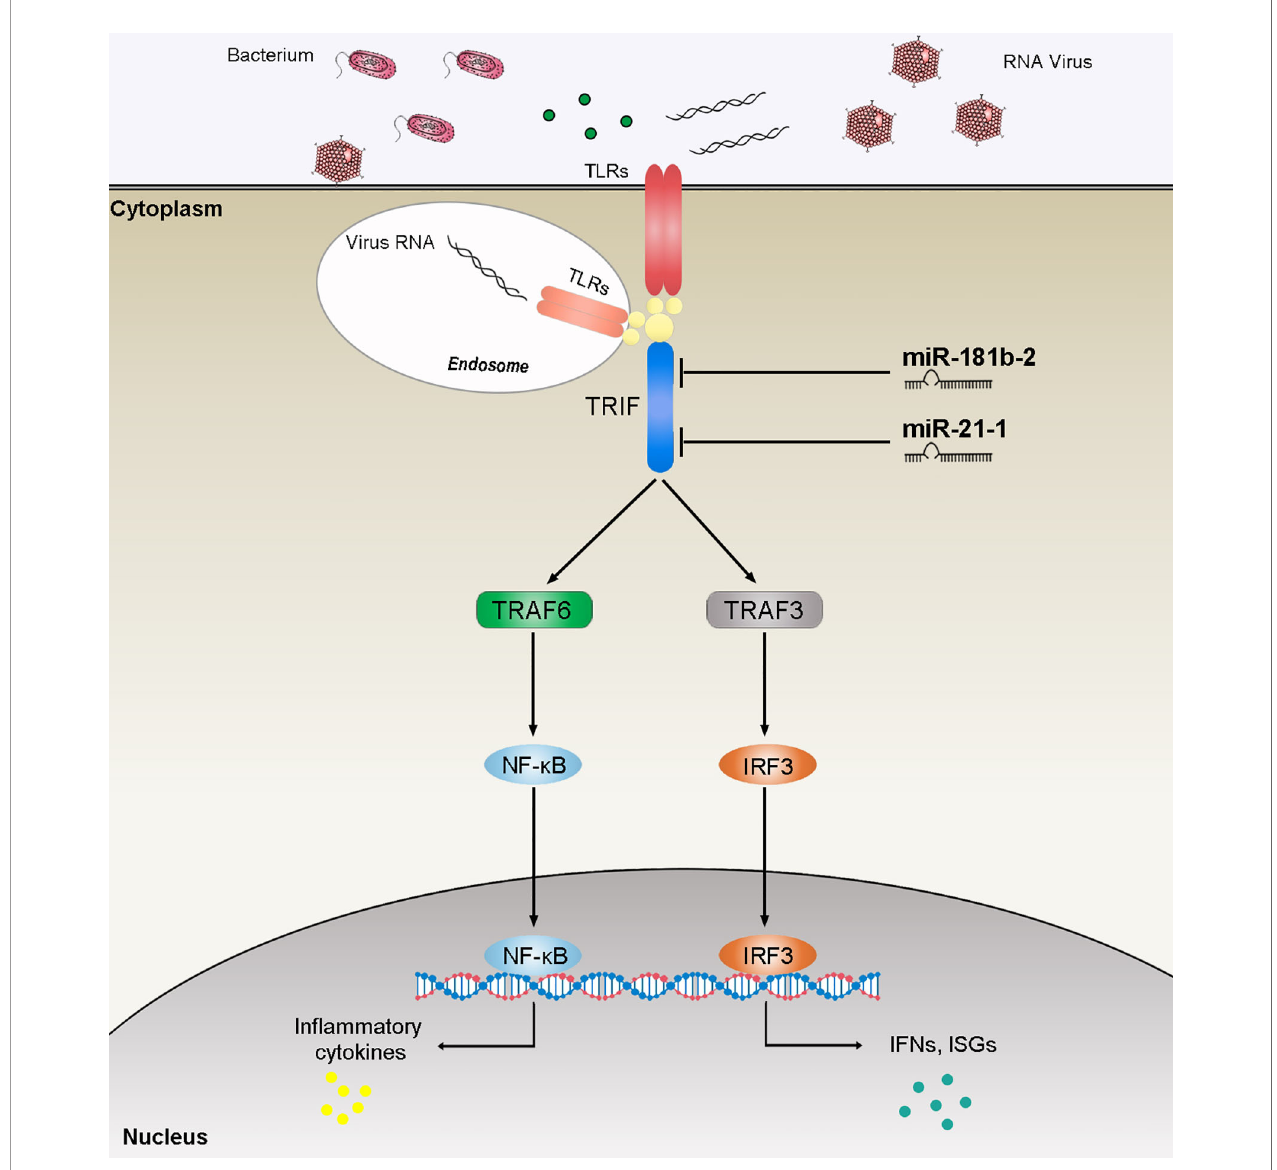
FIGURE 8 | The speculated mechanism model miR-21-1 and miR-181b-2 negatively regulates NF- k B and IRF3 pathway by targeting TRIF. MiR-21-1 and miR- 181b-2 target TRIF and represses TRIF-mediated innate immune